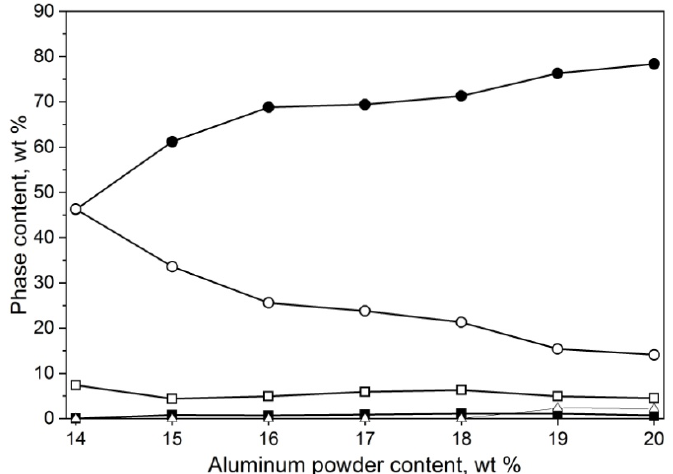
Figure 5. Phase composition of powder mixtures obtained by the means of SHS method from mixes of powders with 14–20 wt% aluminum content with medium alumina under 1 MPa nitrogen with 10% ammonium nitrite, γ -AlON ( ● ), Al 2 O 3 ( ○ ), AlN ( □ ), Al ( ■ ), and Al 7 O 3 N 5 ( ∆ ).